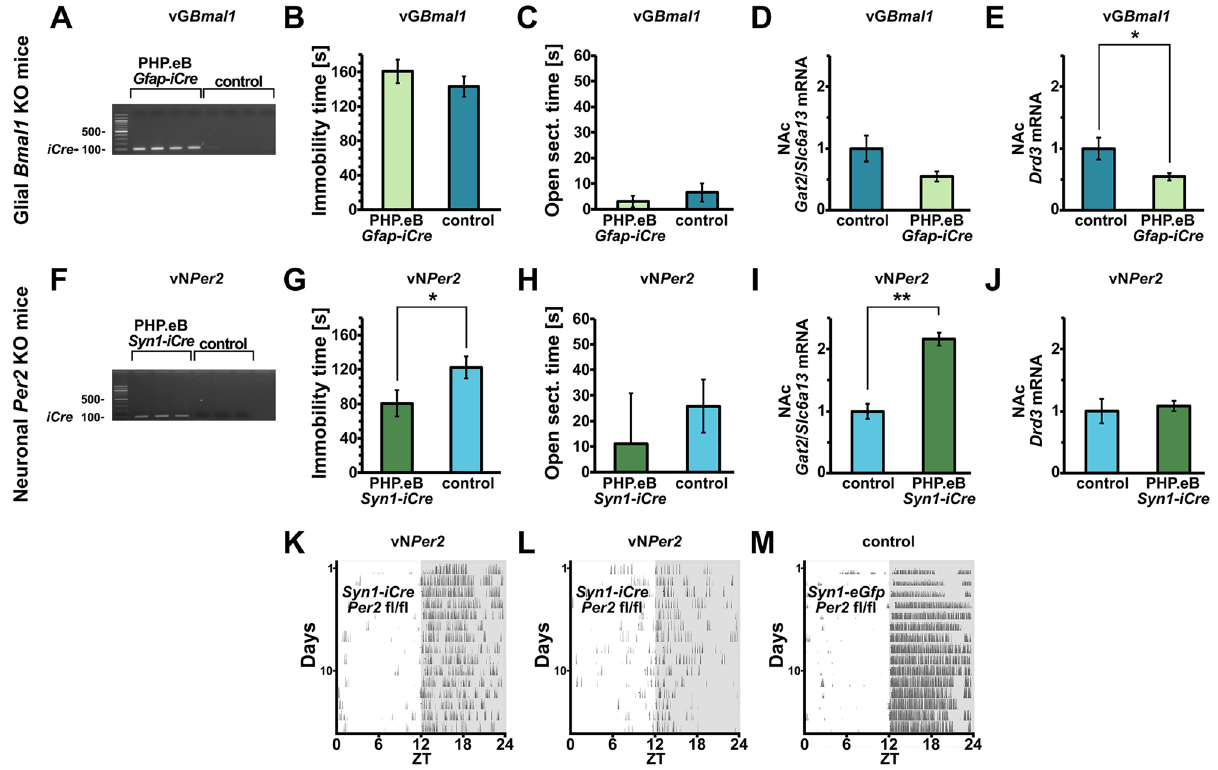
Figure 7. Deletion of Bmal1 in glia does not influence despair- or anxiety-related behavior, while neuronal Per2 deletion influences despair. ( A ) Agarose gel showing the expression of intravenously viral-delivered iCre in total NAc tissue of Bmal1 fl/fl and control animals (n = 4). All probes and markers were loaded on the same gel and the resulting photograph was not separated and recomposed. ( B ) Glial Bmal1 KO mice do not show a difference in the FST (n = 8) or ( C ) O-maze (n = 8). Their NAc expression of ( D ) Gat2 is not significantly reduced, whereas ( E ) Drd3 expression is significantly lower in the KO group (n = 7 or 8, two-tailed t-test, * P < 0.05). ( F ) Agarose gel showing the presence of intravenously viral-delivered iCre in total NAc tissue of Per2 fl/fl and control animals (n = 3). All probes and markers were loaded on the same gel and the resulting photograph was not separated and recomposed. In comparison to vG Bmal1 , vN Per2 mice have ( G ) a reduced immobility time in the FST (n = 11 and 12, respectively, two-tailed t-test, * P < 0.05), but ( H ) show no difference to controls injected with an equivalent virus, but lacking iCre , in the O-maze (n = 11 and 12, respectively). ( I ) Their Gat2 / Slc6a13 expression is upregulated (n = 3, two-tailed t-test, ** P < 0.01), while ( J ) the Drd3 levels are unaltered in the NAc (n = 3). ( K ) A representative vN Per2 mouse shows reduced locomotor activity in a wheel-running cage, as represented with an actogram, where each line represents a day of activity, the latter illustrated with the height and frequency of vertical lines. ( L ) Some KO mice also showed difficulties entraining to the light cycle. ( M ) The mice injected with the control virus, which lacked iCre , showed normal locomotor